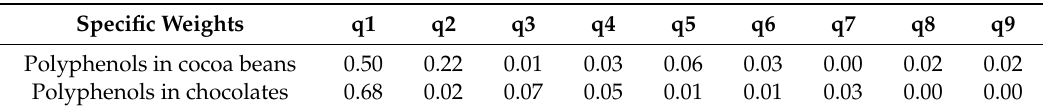
Table 2. Values of the specific weights (%) of each component calculated by the CCSWA with the chocolate polyphenolic data and cocoa polyphenolic data.